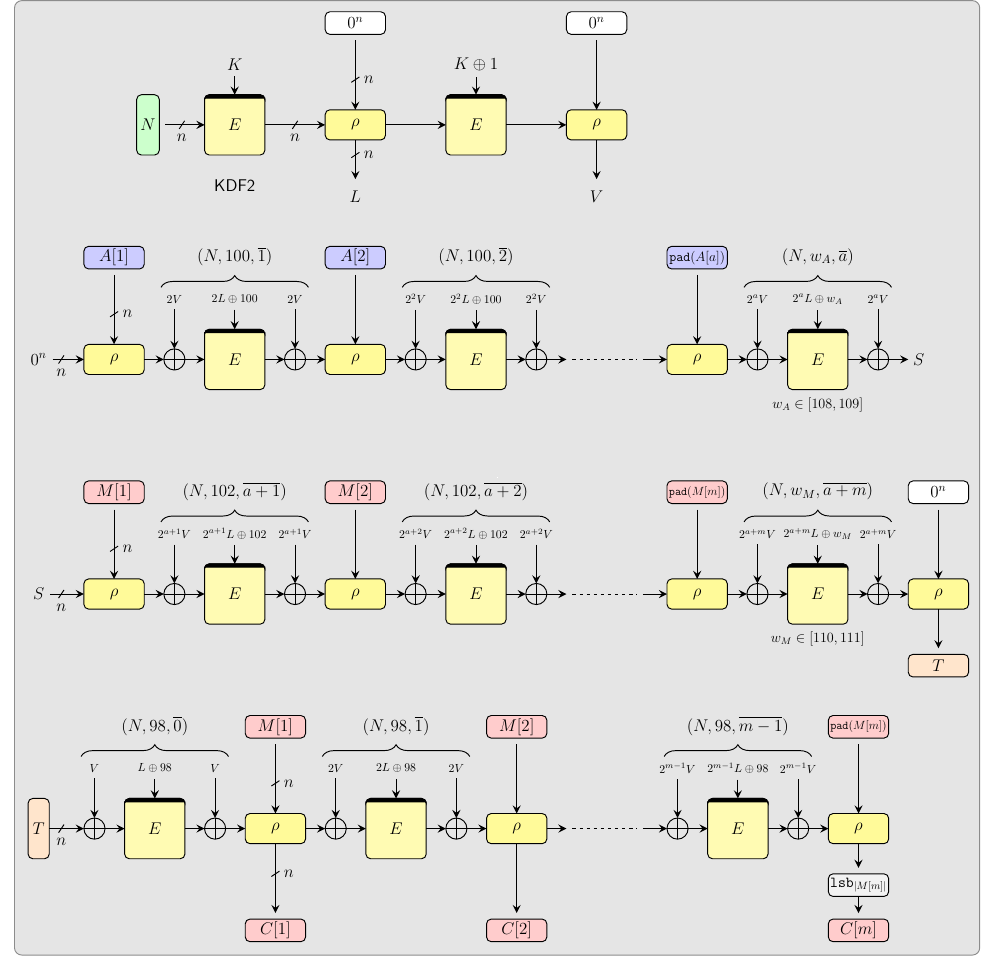
Figure 12: Remus-M with ICE2 ( Remus - M 2). (Top) Key derivation. (Middle-Top) Processing of AD (Middle-Bottom) Processing of M authentication (Bottom)